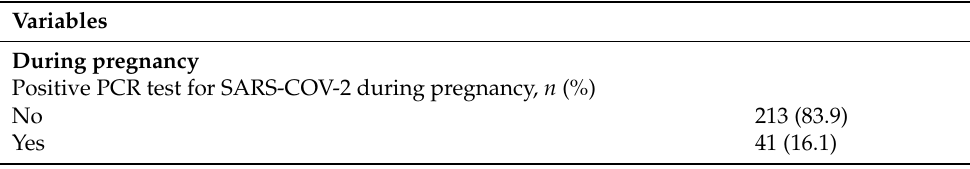
Table 4. Answers related to stress factors related to the COVID-19